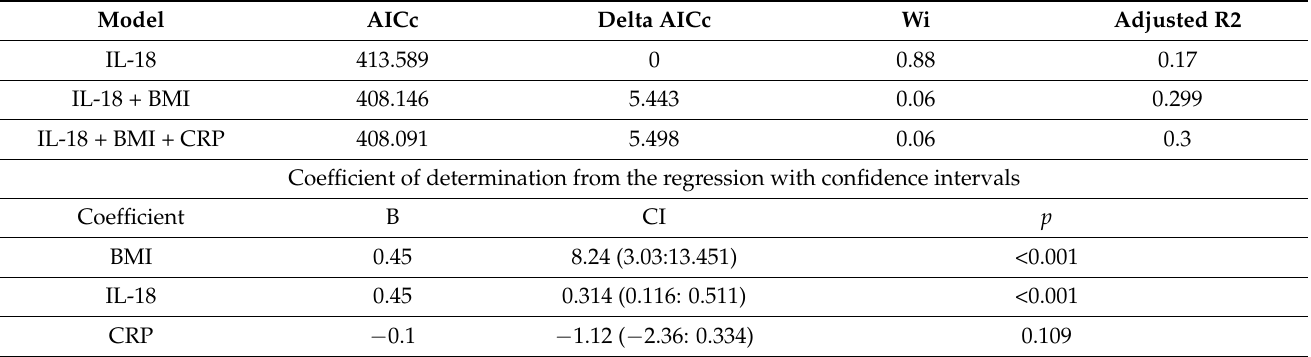
The coefficient of determination—R2 Sampling weights–Wi. Akaike information criterion—AICc. Confidence interval—CI. B—beta